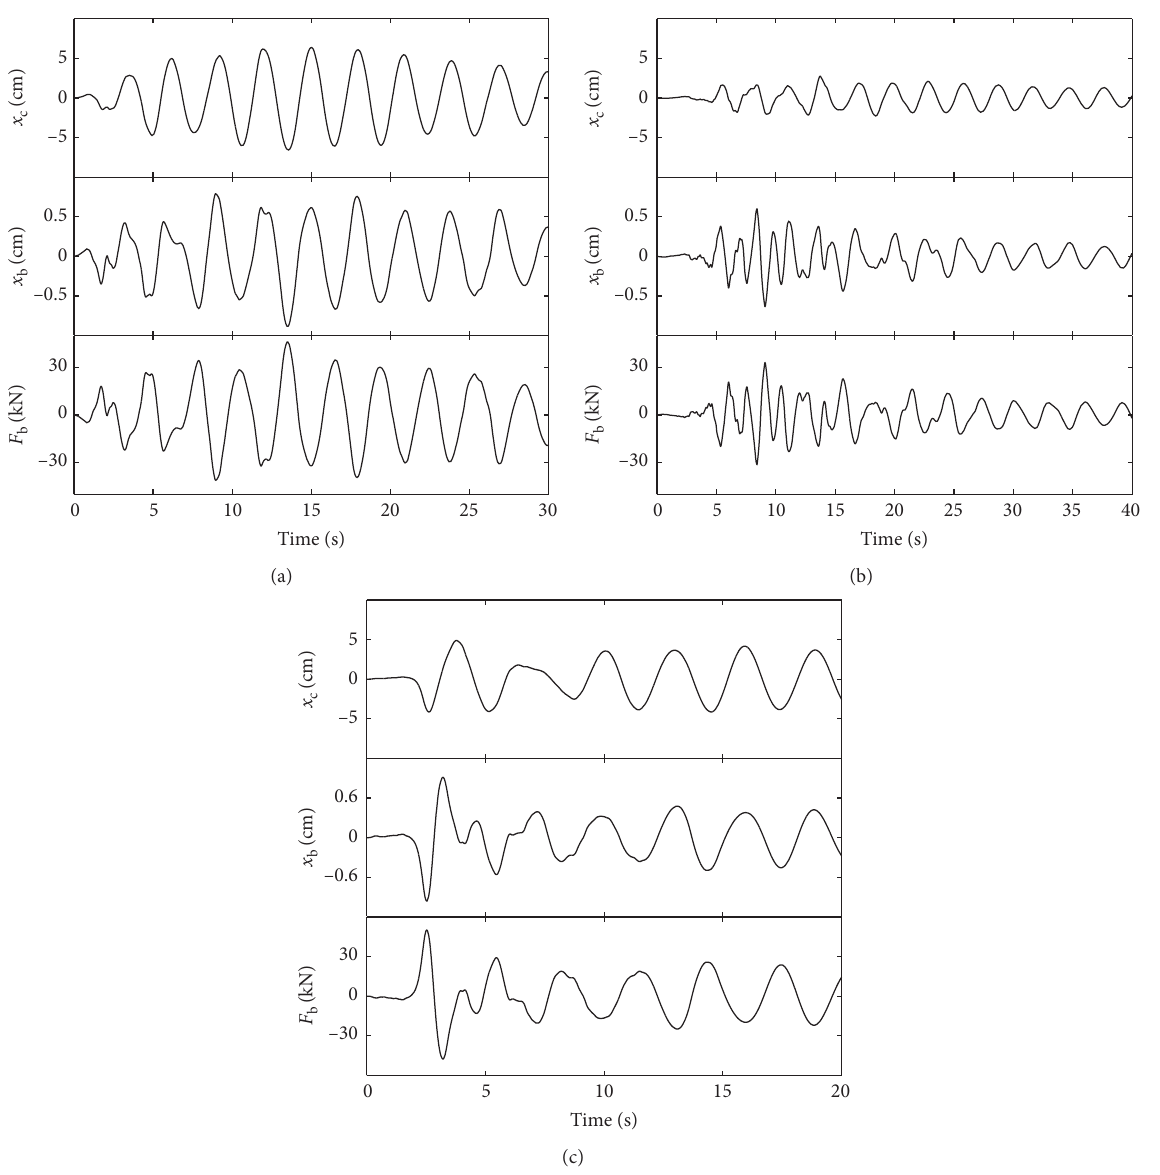
Figure 4: Time-history response of stick model for water storage tank subjected to various ground motions (isolation period T � 0 . 1): (a) El Centro record; (b) Capitola record; (c) Rinaldi record. damping ratio ξ b